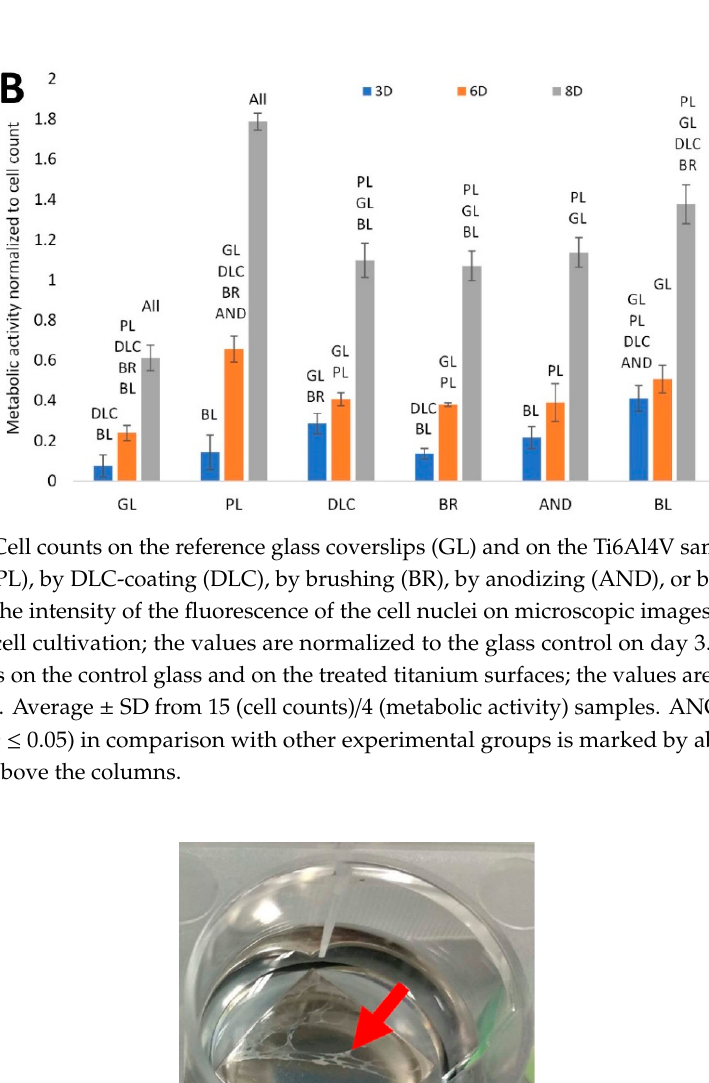
Figure 5. A cell layer peeled off the smooth surface of a polished sample (arrow). This phenomenon was observed on all samples with roughness below 25 nm, i.e., GL, PL, and DLC, but it was most noticeable on PL. These samples were excluded from the analysis.